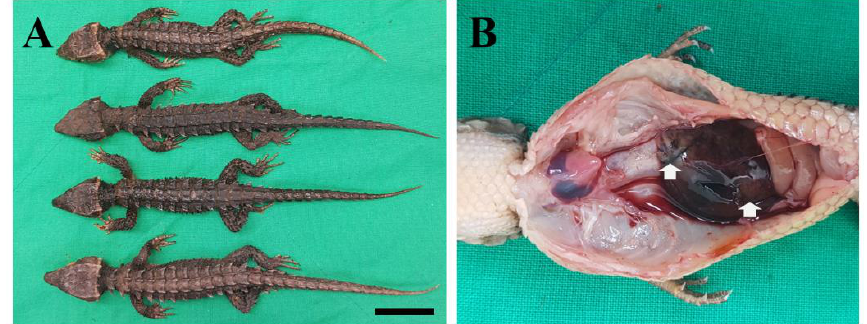
Figure 1. Findings of the examinations. ( A ) Gross examination (bar = 3 cm) and ( B ) hepatic lesions (white arrow) seen at necropsy.